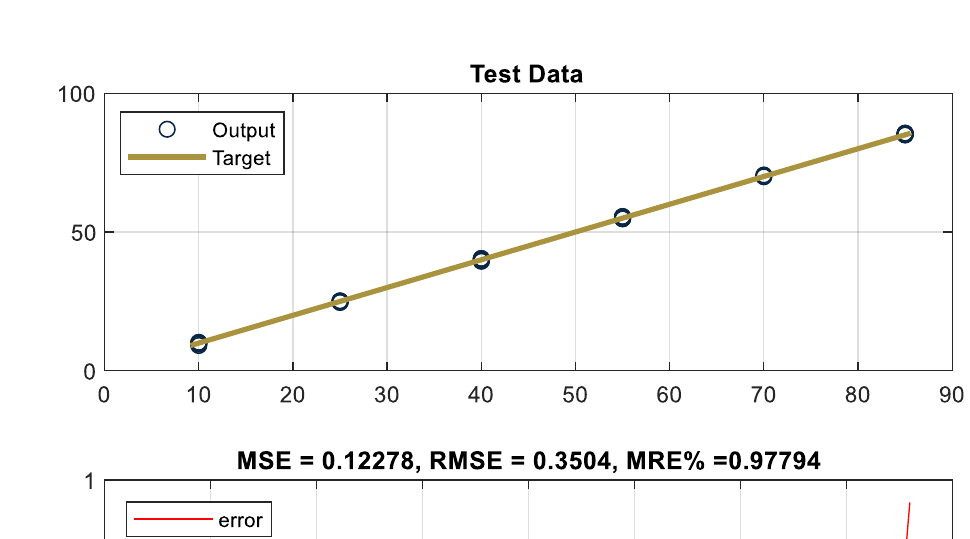
Figure 6. The structure of designed network.